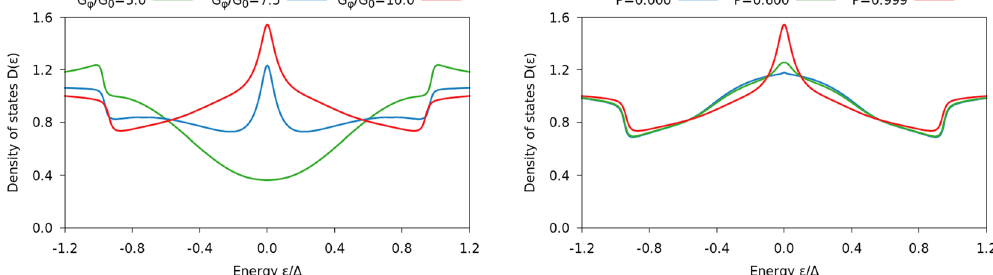
Figure 4. Plots of the DOS at the superconducting side of the interface in an S/FI/N junction with L S = 3 ξ S and L N = 10 ξ S as function of energy. The ferromagnetic insulator was modelled as a spin-active interface with very strong spin-mixing and polarization: in the left plot, we set the polarization P = 0.999 and vary G ϕ , in the right plot we set G ϕ / G 0 = 10 and vary P . In contrast to Figs 2 and 3, we also included a magnetic inhomogeneity in the model, which was incorporated by using two different magnetizations m L = e x and m = m R = e z in the spin- active boundary conditions.